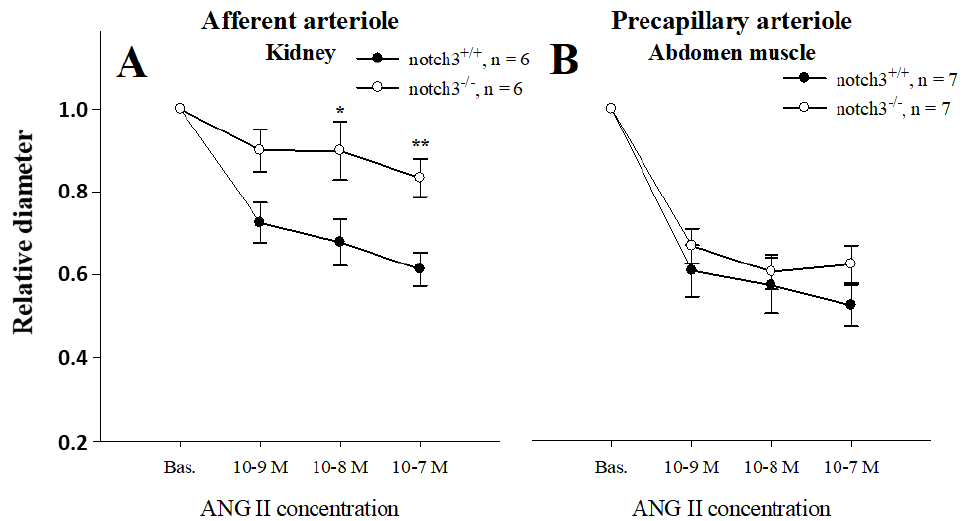
Figure 1. Lumen diameter dose-responses to angiotensin II (ANG II) in isolated afferent arterioles (AAs) revealed reduced contractile ability in renal vessels lacking Notch3 expression ( A ). In con- trast, precapillary arterioles from abdominal muscle displayed similar contractions to ANG II ( B ). *, ** p < 0.05 and p < 0.01, respectively, vs. wild-type.